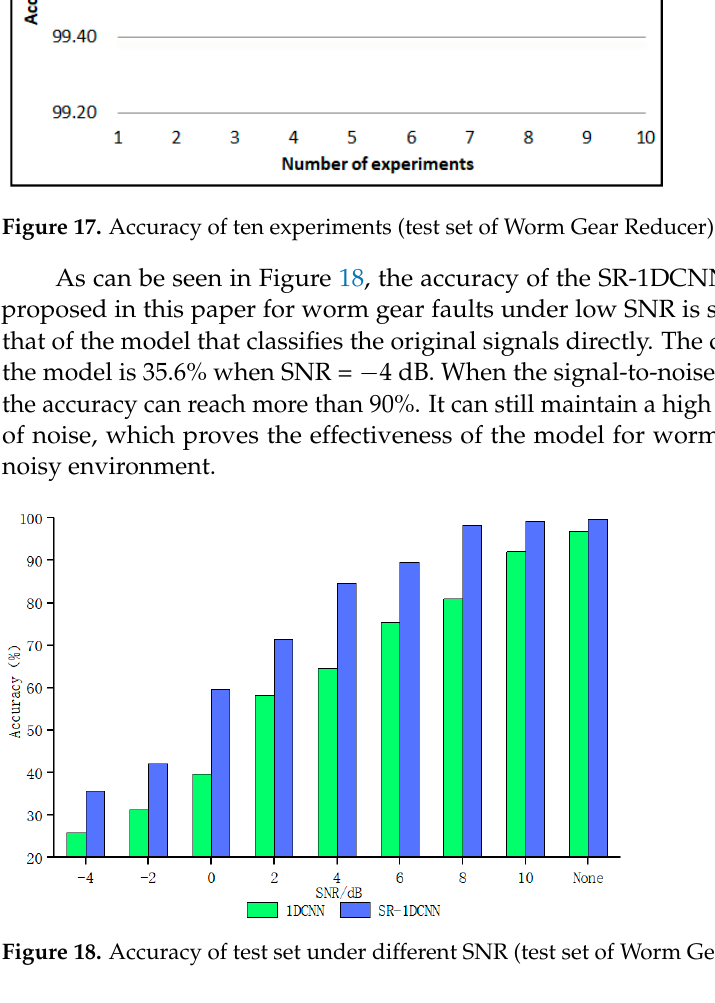
Figure 18. Accuracy of test set under different SNR (test set of Worm Gear